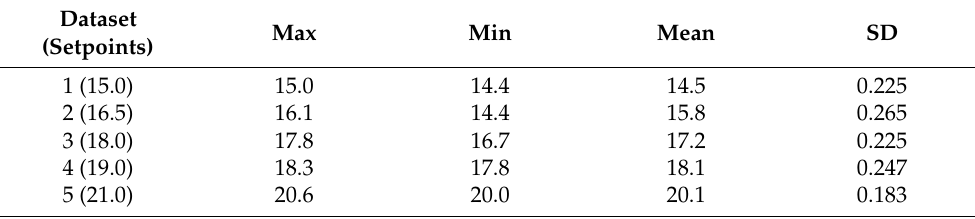
Table 1. Temperature data registered by Tilt sensor. All values are given in ° C. Dataset (Setpoints)